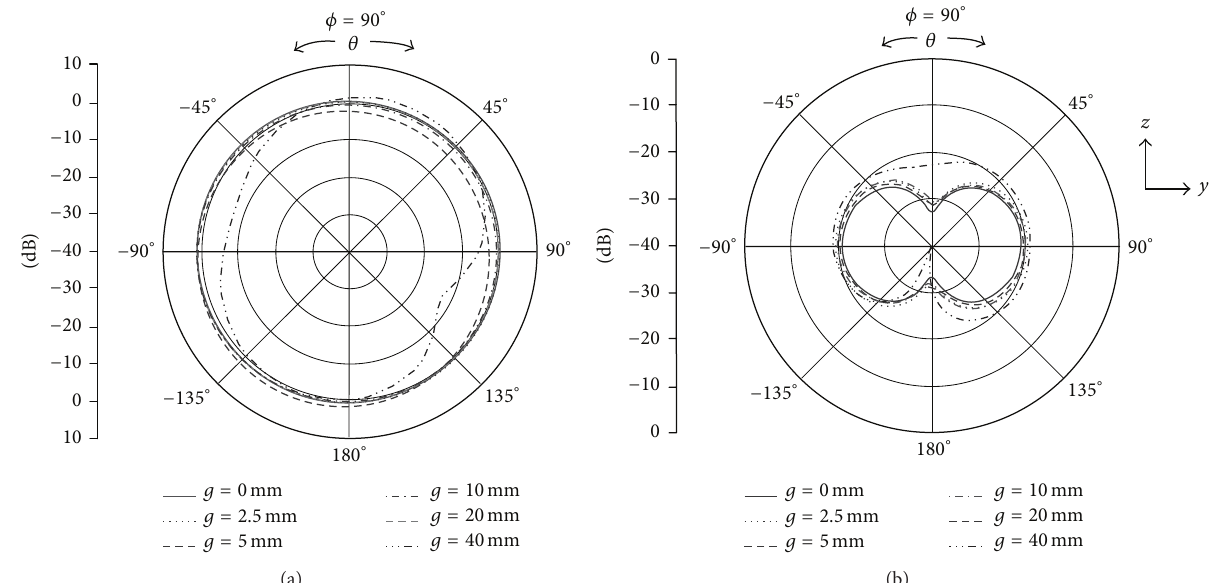
Figure 13: Simulated radiation patterns in the 𝑦 - 𝑧 plane at respective resonant frequencies as a function of 𝑔 (a) copolarization (𝐸 𝜙 ) , (b) cross-polarization (𝐸 𝜃 )